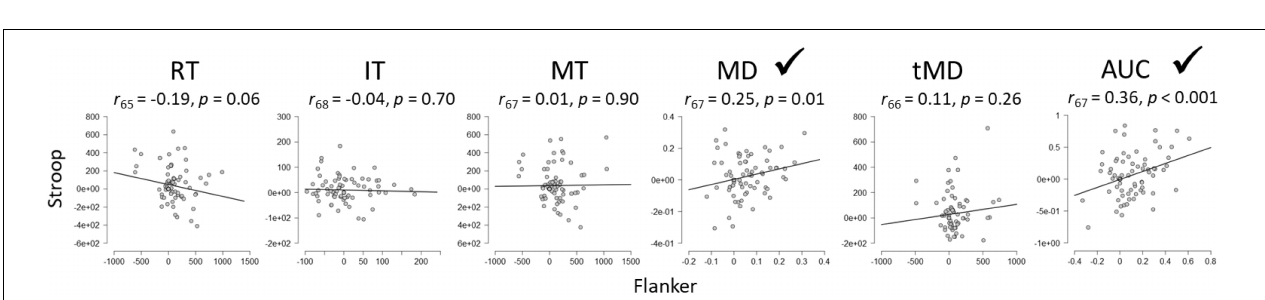
FIGURE 5 | Within-task split-half (odd vs. even trials) reliabilities of the SCE for Flanker and Stroop tasks. RT, Reaction Time; IT, Initiation Time; MT, Movement Time; MD, Maximum Deviation; tMD, Time to Maximum Deviation; AUC, Area Under the Curve. Checkmarks indicate significant correlations ( p < 0.05). Significant reliability (i.e., positive Pearson r correlation coefficients) after Spearman-Brown prophecy correction are marked with a check mark. Un-bolded values above the graphs represent Pearson r correlation coefficients without correction, and bolded values represent Pearson r correlation coefficients after Spearman-Brown correction.